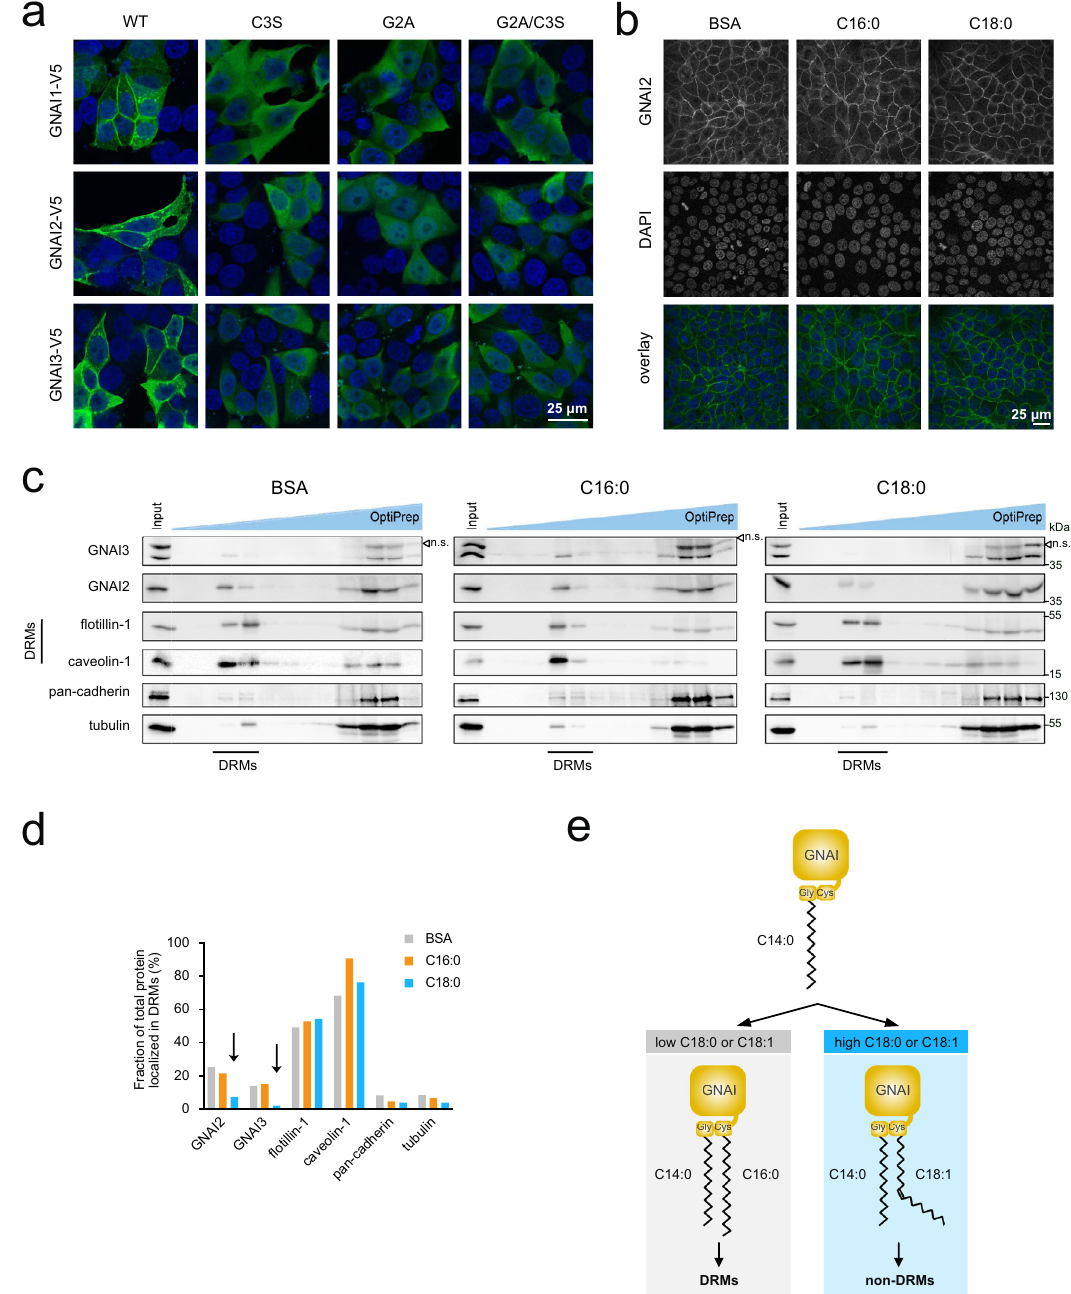
Fig. 4 Exposure of cells to C18:0 shifts GNAI proteins out of detergent-resistant membranes (DRMs). a S-acylation of GNAI proteins is required for their membrane localization. Unlike wild-type (WT) GNAI proteins, GNAI mutants lacking S-acylation do not localize to the plasma membrane, detected by immunostaining (green: anti-V5, blue: DAPI, scale bar 25 μ m). Representative of three biological replicates. b Exposure of cells to C18:0 or C16:0 does not alter the localization of endogenous GNAI2 to the cell membrane, detected by immunostaining (green: anti-GNAI2, blue: DAPI, scale bar 25 μ m). Representative of two biological replicates. c , d Endogenous GNAI2 and GNAI3 are depleted from DRMs upon exposure of cells to C18:0 but not C16:0. DRMs are isolated by the protein fl otation assay in discontinuous OptiPrep gradients after solubilization with 1% Triton X-100 ( c ). As markers of DRMs, fl otillin-1 and caveolin-1 were used. Quanti fi cation of the relative amount of each protein in DRMs normalized to total cell content of that protein (sum of all fractions) is shown in ( d ). Representative of three biological replicates. e Schematic diagram summarizing the fi ndings presented here on GNAI